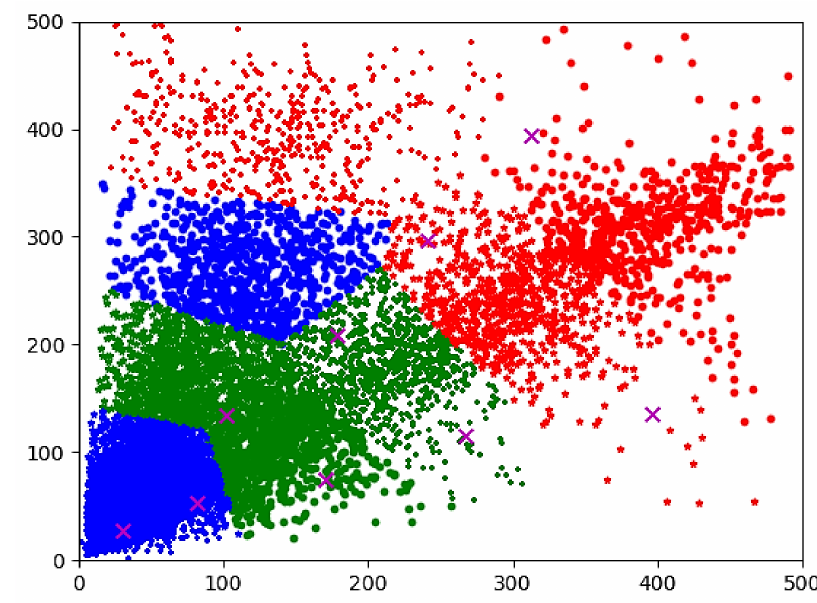
Figure 6. Clustering results of anchor boxes.